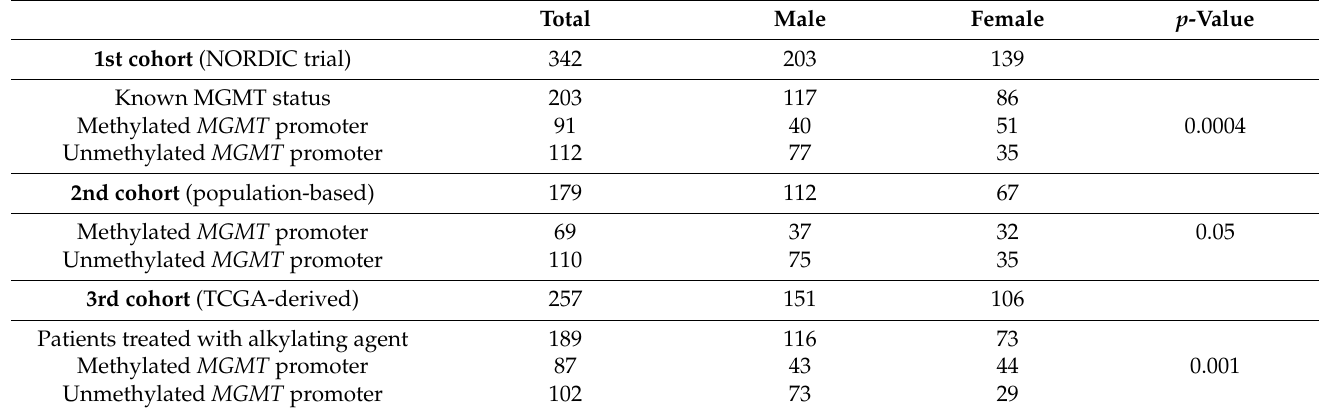
Table 1. Clinical parameters of patients included in the three different cohorts. Total p